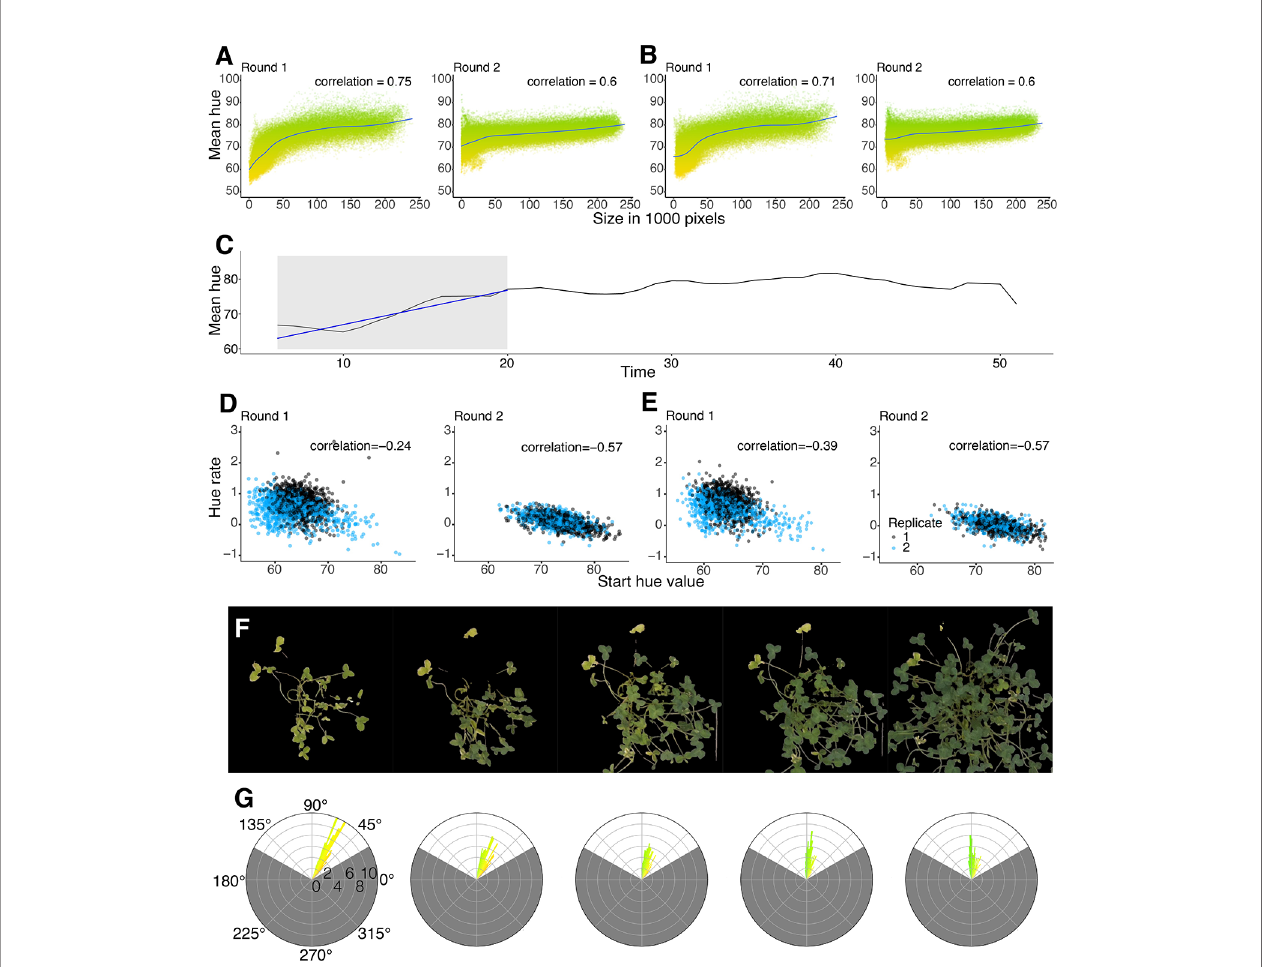
FIGURE 5 | (A, B) Correlation between the mean of the hue and the size of the plant. Y-axis shows the hue ranges from Yellow (50°) to Green (100°). All time points across all plants are included on the fi gure. Comparison between Thresholding (A) and U-net (B) showing the difference between round 1 and round 2 for each method. (C) Example of how the RateOfHue was estimated. The grey area corresponds to the mean hue values fi t with a linear regression. The regression curve is drawn with a blue line. The rate of hue corresponds to the slope of the regression. (D, E) Pearson correlations between the rate of hue and the starting hue value of round 1 and round 2 for Thresholding (D) and U-net (E) across all plants. (D) Round 1 has a -0.24 Pearson correlation and round 2 has a -0.57 Pearson correlation. (E) Round 1 has a -0.39 Pearson correlation and round 2 has a -0.57 Pearson correlation. (F) Graphical example of a single plant changing color over time. The masks were produced using U-net. (G) Circular histograms of the hue distribution from the corresponding masks above. The scales around the histogram are the degree value of the hue, and the scale within is the percentage of the count with a particular hue value. The gray area of the circular histogram corresponds to the hues fi ltered by the mask. The colors of the bars in the histogram indicate the hue of the pixels in the corresponding